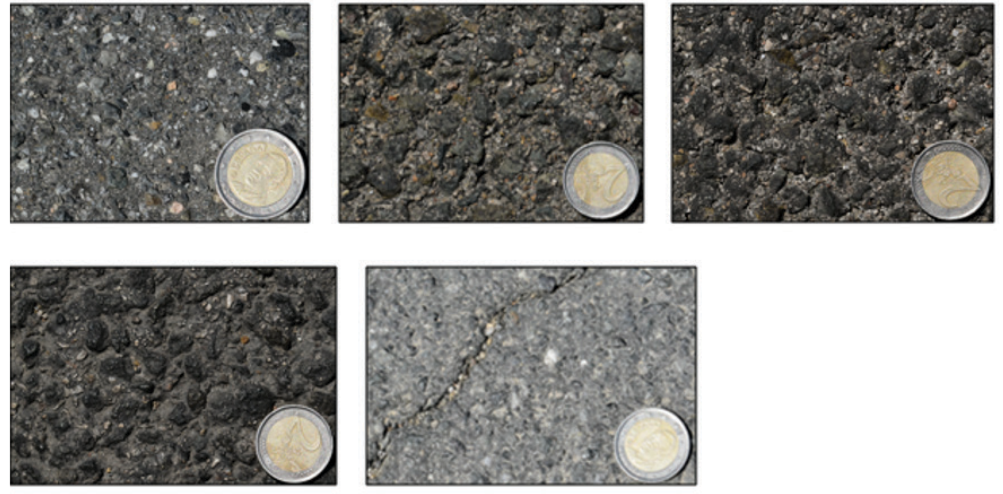
Figure 6. Photographs of the Test Tracks 1 to 5 (from left to right and up to